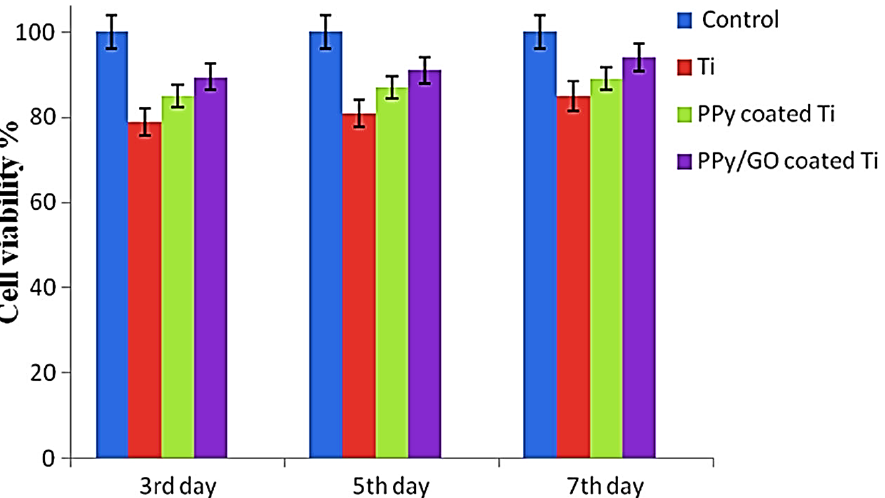
Figure 9. In vitro MG-63 cell culture studies according to confocal images with MTT assay results for Ti, PPy coating, and PPy/GO composite-coated Ti [102]. MTT = cell proliferation assay. PPy/GO = polypyrrole/graphene oxide. Reproduced with permission from Springer.